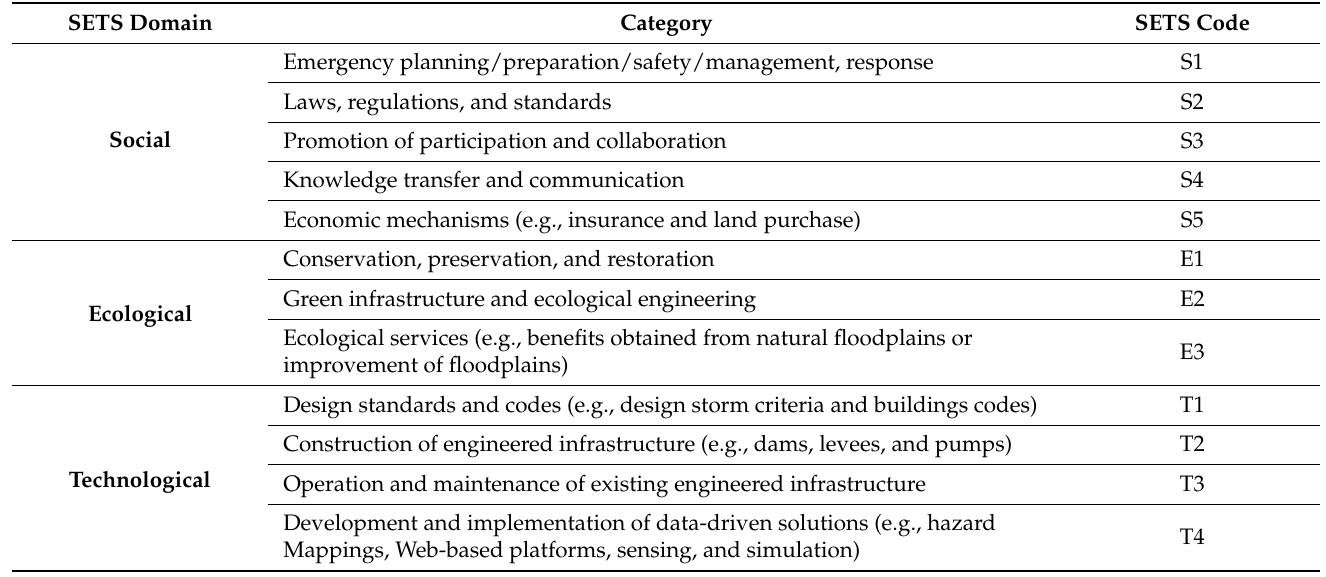
Table 1. SETS domains and codes.